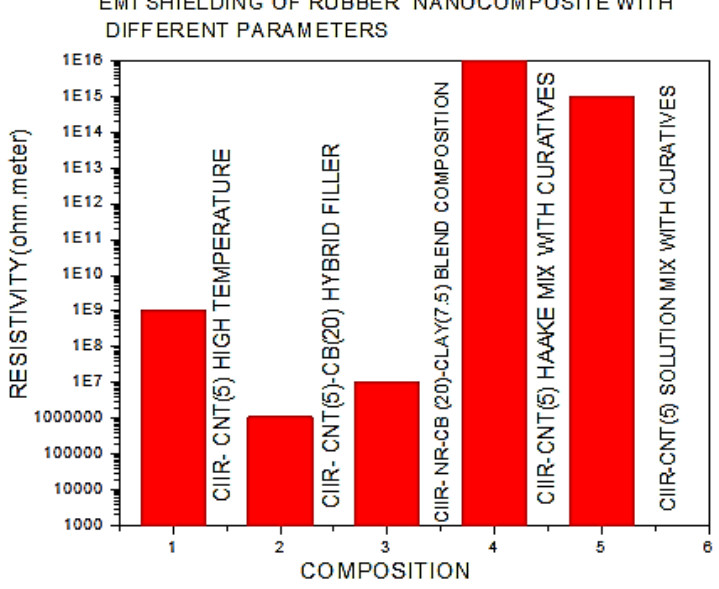
in NR/CIIR Figure 9. Resistivity – composition graph of hybrid filler composition and blend rubber nanocom- posite in NR/CIIR matrix.